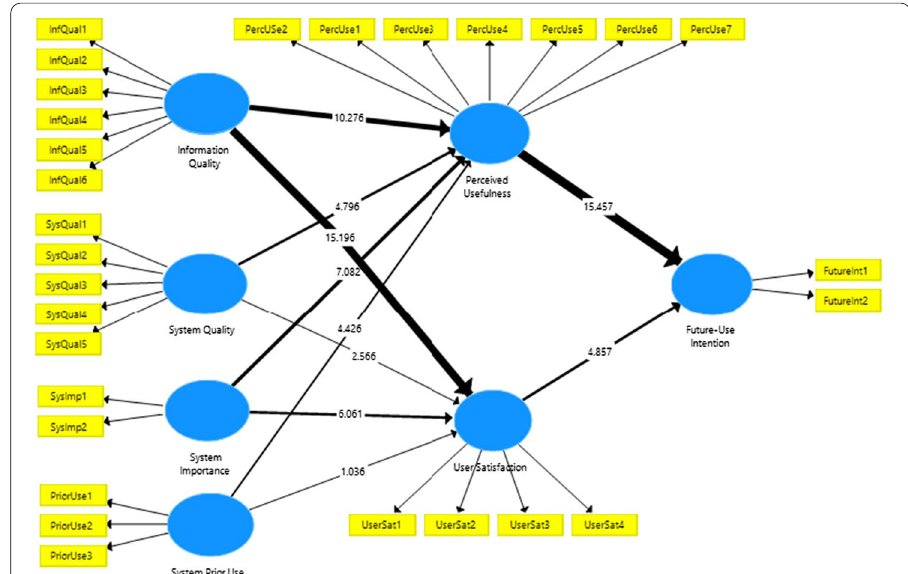
Fig. 5 Structural path T-values estimation